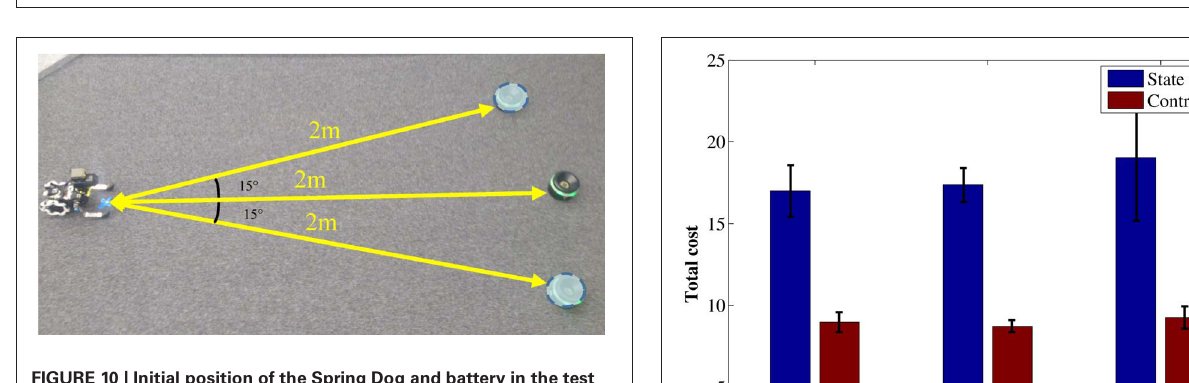
performance using the obtained control policy was comparable to